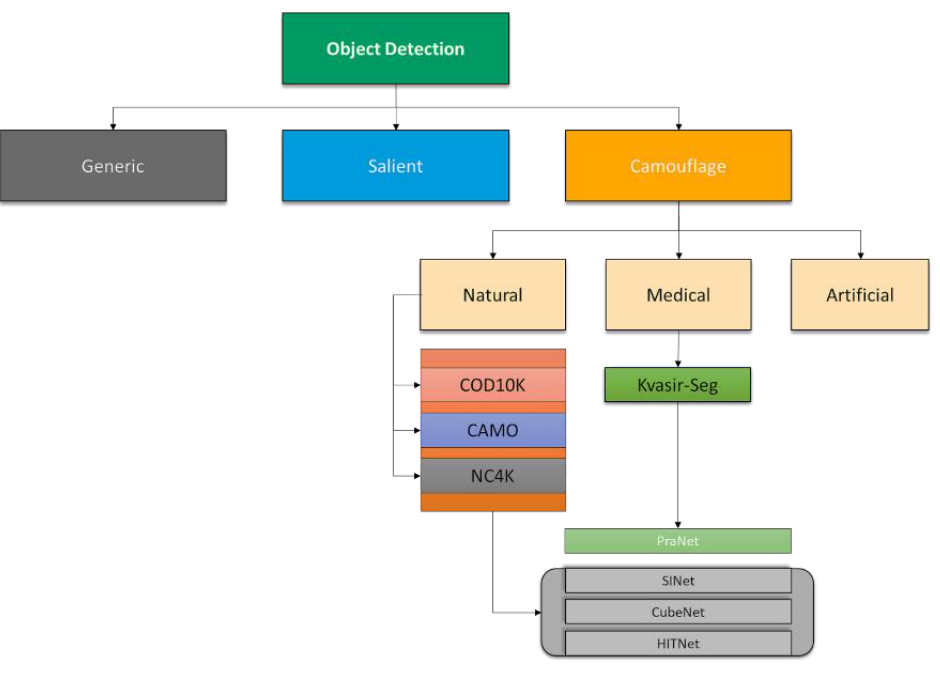
Figure 4. Object Detection Organogram.